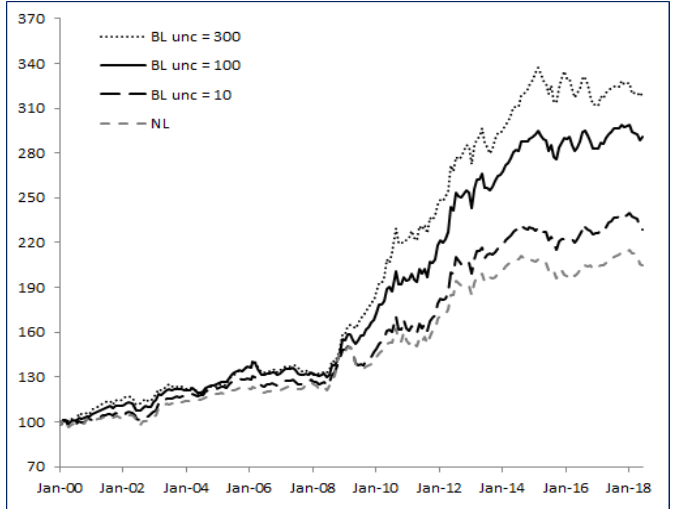
Figure 3. Historical values of the BL portfolios calculated with unc = 10,100,300 and NL .